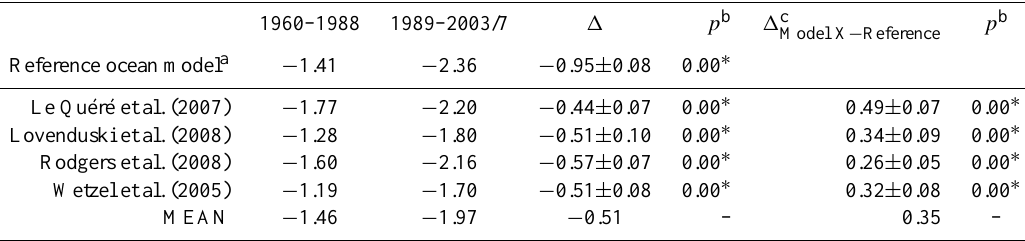
Table 2. Mean of ocean uptakes in the ocean models in Fig. 1b for the periods 1960–1988 and 1989–2003/7 and the difference 1 =1989– 2003/7 minus 1960–1988. Only the reference model and Le Qu´er´e et al. (2007) models were run out to 2007, The Wetzel et al. (2005) model was run out to 2003, and the Rodgers et al. (2008) and Lovenduski et al. (2008) models were run out to 2004 (see Appendix A). Also shown is 1 Model X − Reference =1989–2003/7 average minus 1960–1988 average of the year-by-year difference between each model (Model X) minus the reference constant climate model of Mikaloff Fletcher et al. (2006). The mean ocean uptakes are calculated using the annual mean ocean uptake to remove the